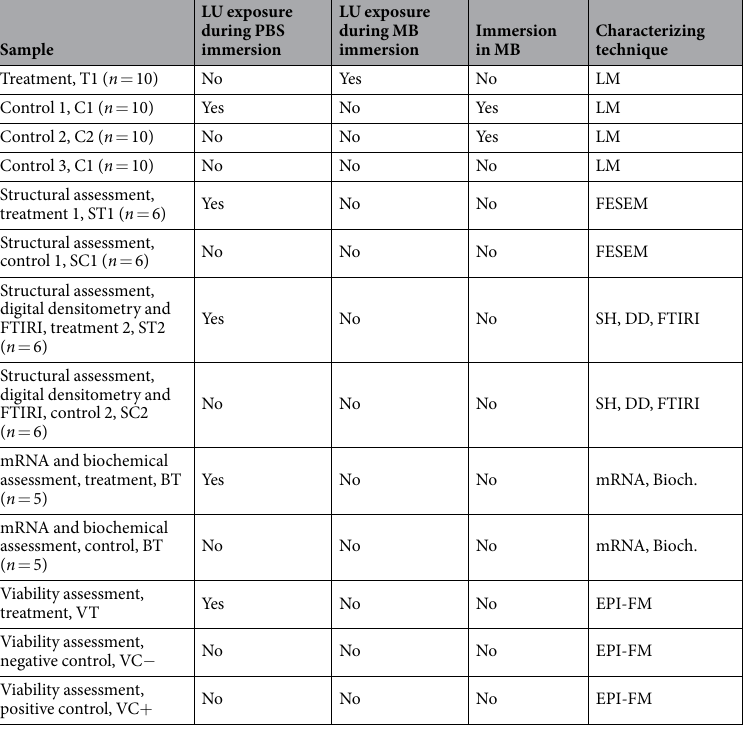
Table 1. Summary of experimental procedures by sample group. The procedures for each sample were applied chronologically from the far left column towards far-right column. LU = laser-ultrasound. PBS = phosphate- buffered saline. MB = methylene blue (0.005% w/v) in PBS. LM = light microscopy in transmission mode at peak wavelength 657 nm. EPI-FM = EPI fluorescence microscopy. FESEM = field emission scanning electron microscopy. FTIRI = Fourier transform infrared imaging (Amide I absorption, collagen). SH = standard